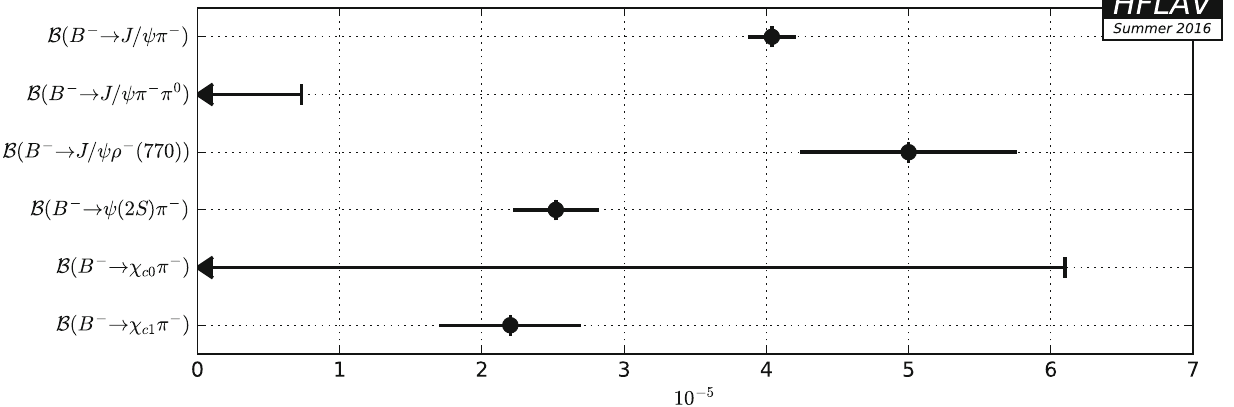
Fig. 133 Summary of the averages from Table 164